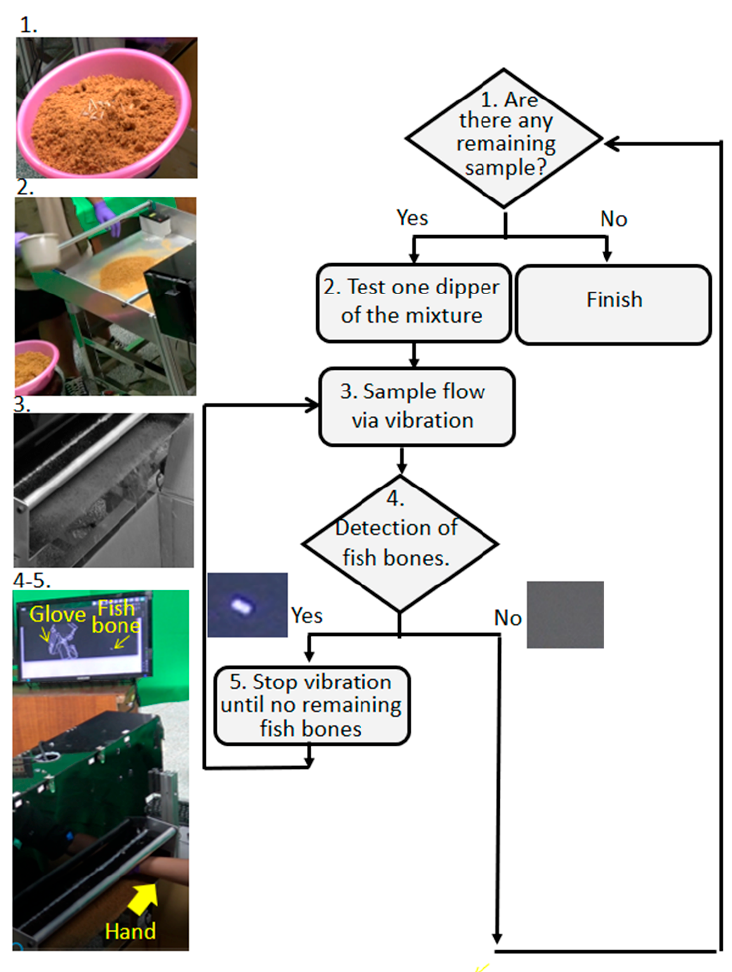
Figure 3. Control program for performance tests.